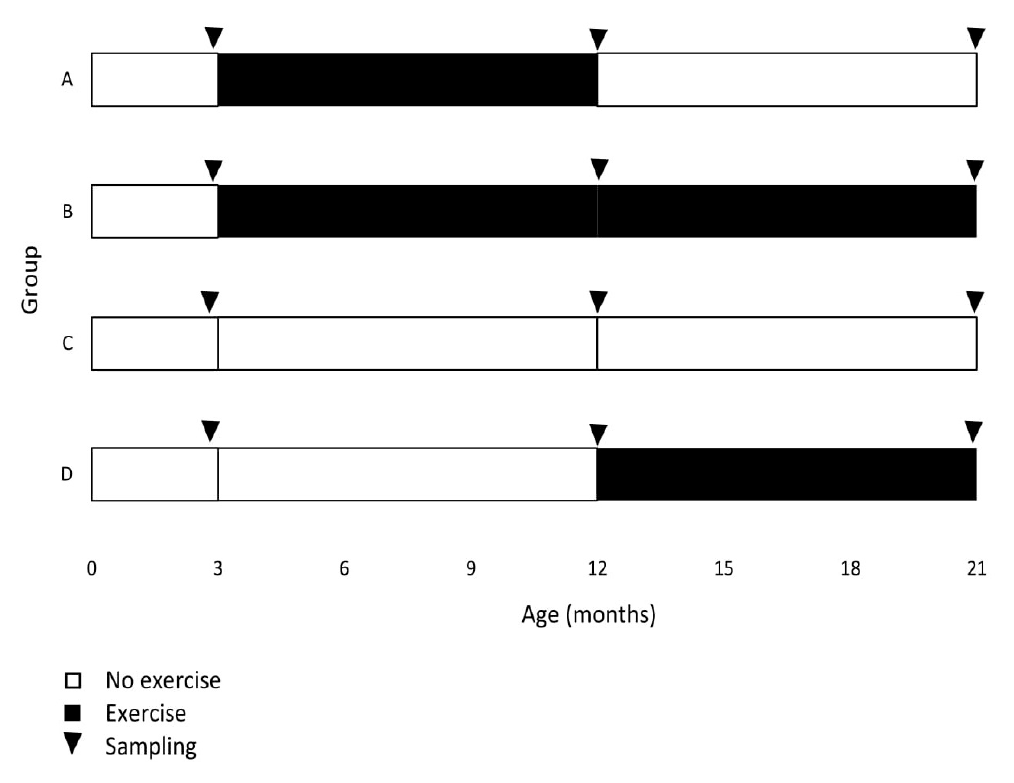
Figure 5. Study design showing the interventions on the four groups of rats. Solid bars denote exercise training, open bars denote no exercise, and arrowheads denote urine sampling.